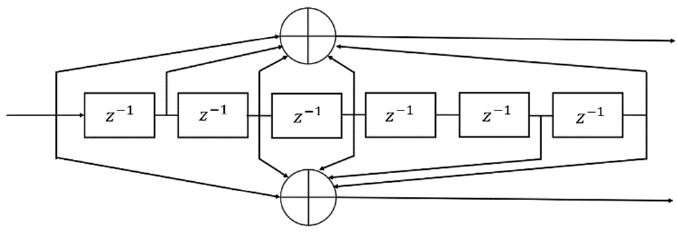
Figure 14. Encoder for rate R = ½, and constraint length K = 7 convolutional